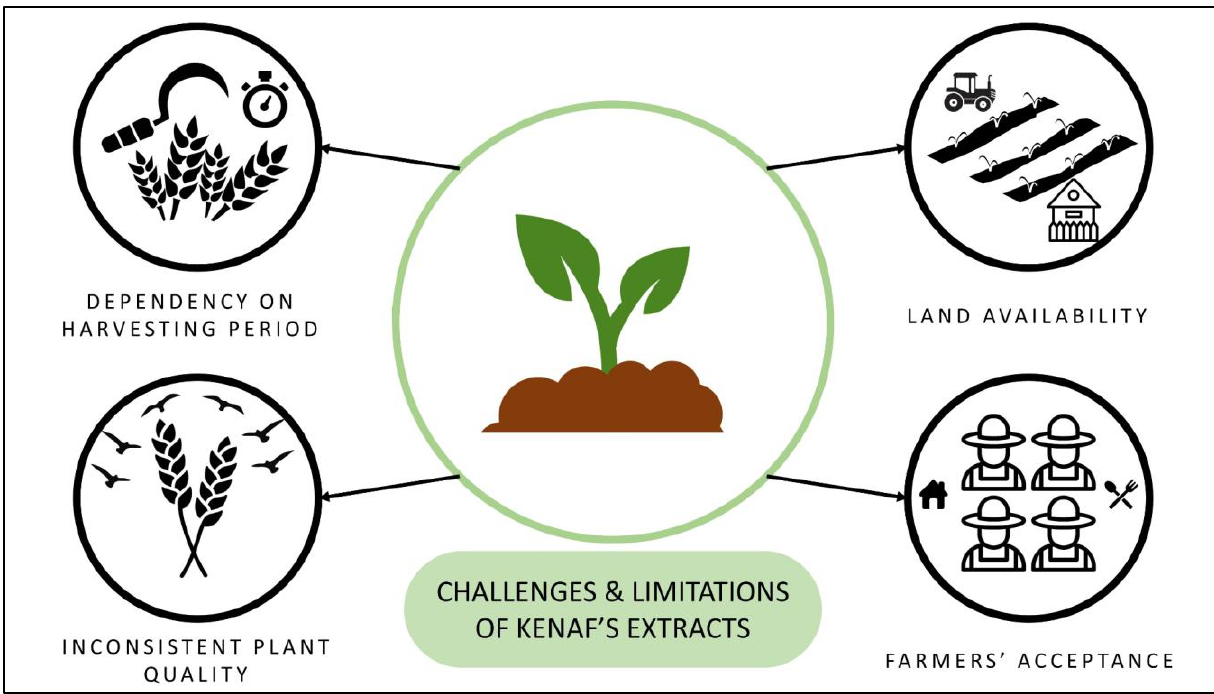
Figure 11. Challenges and limitations of kenaf extracts.